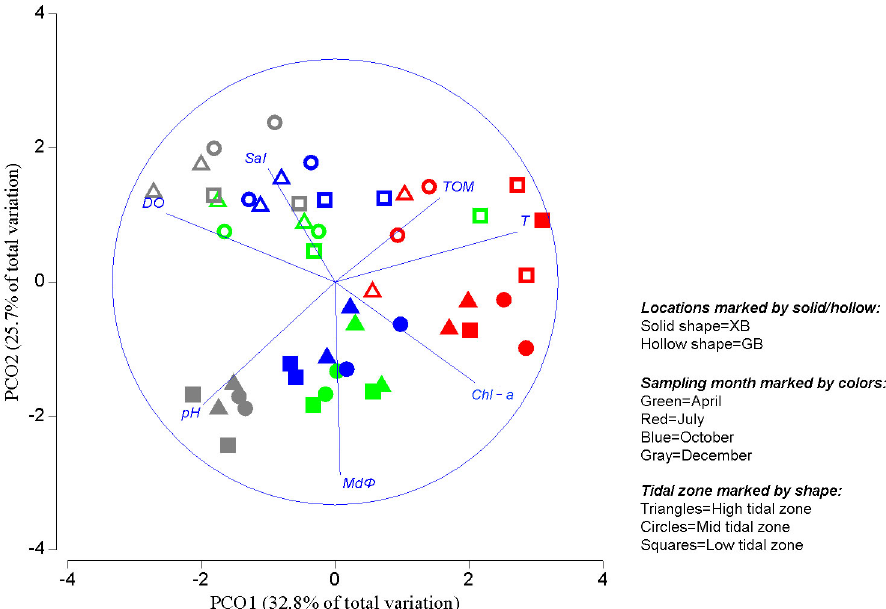
Figure 2. Principal coordinates analysis (PCO) output based on environmental variables. Vectors are the Pearson correlations of variables with the PCO axes. Abbreviations: XB, Xiajiahezi Beach; GB, Golden Beach; T, sea water temperature; Sal, sea water salinity; DO, sea water dissolved oxygen; Chl-a, Chlorophyll-a; TOM, total organic matter; Md Φ , medium particle diameter. Table 2. Environmental variables of the two studied beaches in four sampling months. Abbreviations: XB, Xiajiahezi Beach; GB, Golden Beach; T, sea water temperature; Sal, sea water salinity; DO, sea water dissolved oxygen; Chl-a, Chlorophyll-a; TOM, total organic matter; Md Φ , medium particle diameter. H, high tidal zone; M, mid-tidal zone; L, low tidal zone.